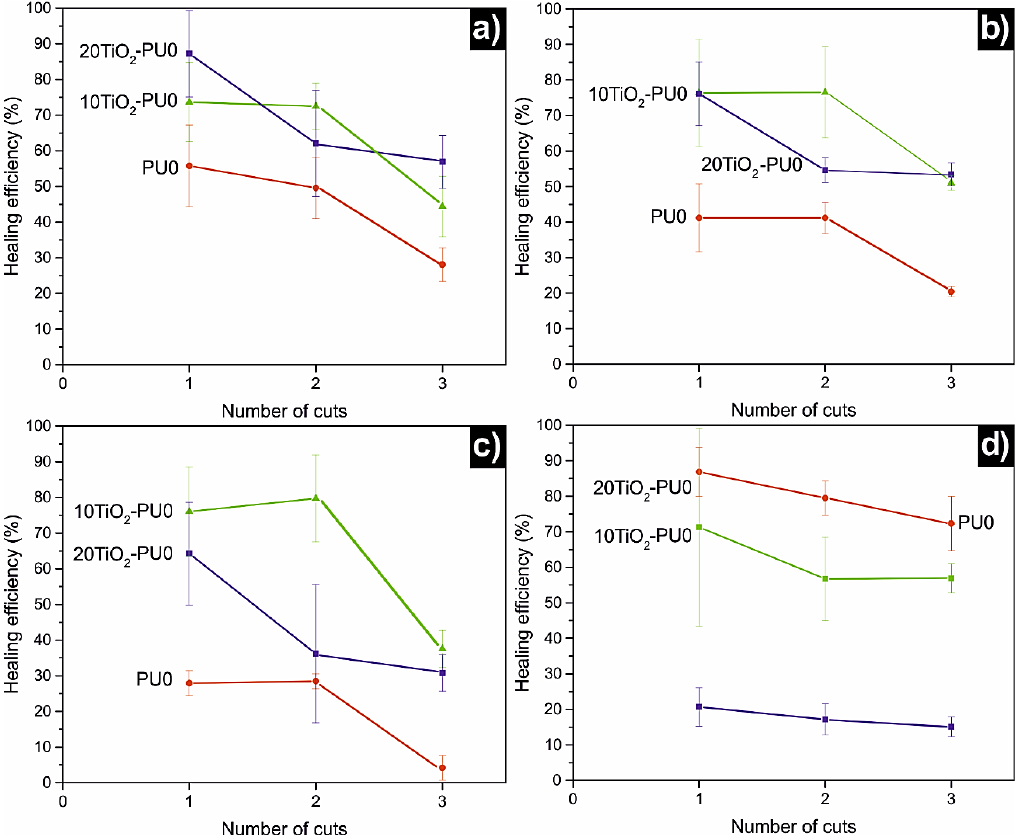
Figure 6. The healing efficiency of PU0, 10TiO 2 -PU0 and 20TiO 2 -PU0 for ( a ) Young’s modulus, ( b ) tensile strength, ( c ) stress at break, ( d ) deformation at break.